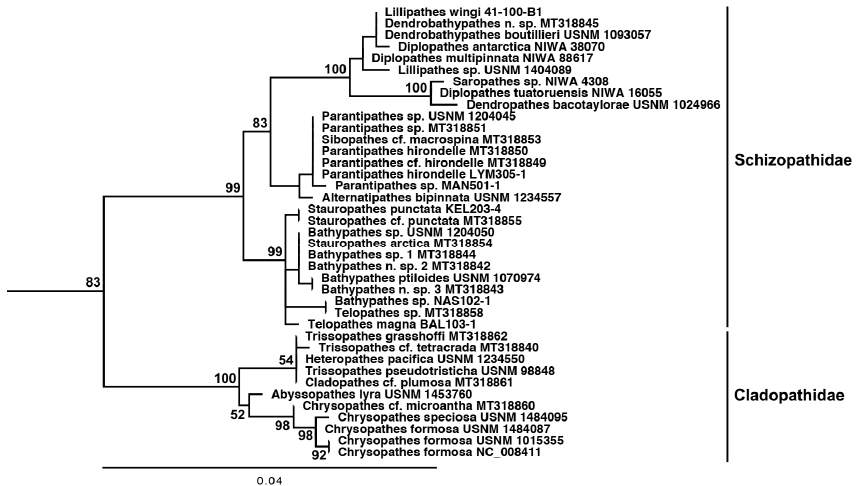
Figure 7. Partial results of a maximum likelihood-based phylogenetic reconstruction using mitochondrial cox1 sequence data focusing specifically on the families Cladopathidae and Schizopathidae. The MAFFT LINS-i v7-based alignment consisted of 88 sequences and 626 sites. Akaike Information Criterion within jModelTest v2.1.1 selected the GTR+I+G model of sequence evolution (p-inv: 0.5690; gamma shape: 1.6810). IQ-Tree v2.1.2 utilized a BioNJ starting tree. Node support is based on